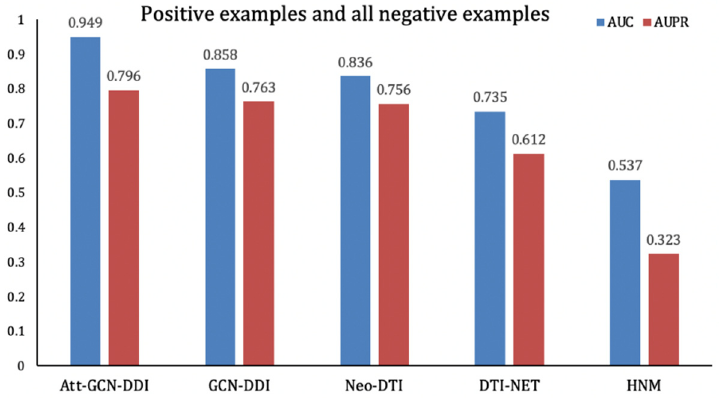
Figure 5. Comparison results of Att-GCN-DDI and previous methods in the second scenario.